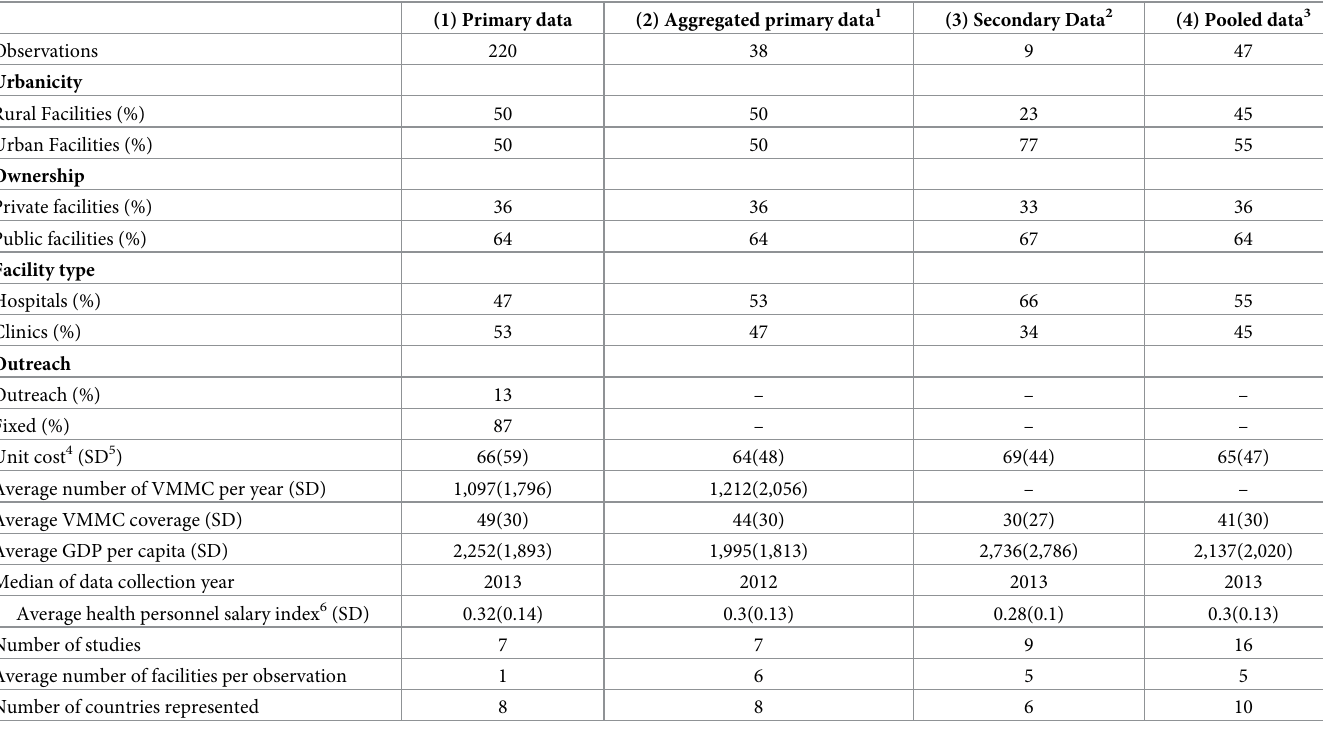
Table 1. Description of data–primary, secondary and pooled